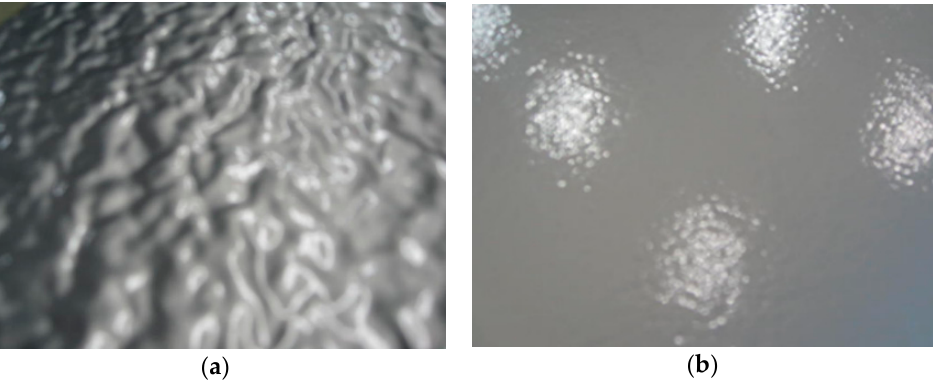
Figure 6. Comparison of insulation surface: ( a ) Conventional; ( b ) Improved.